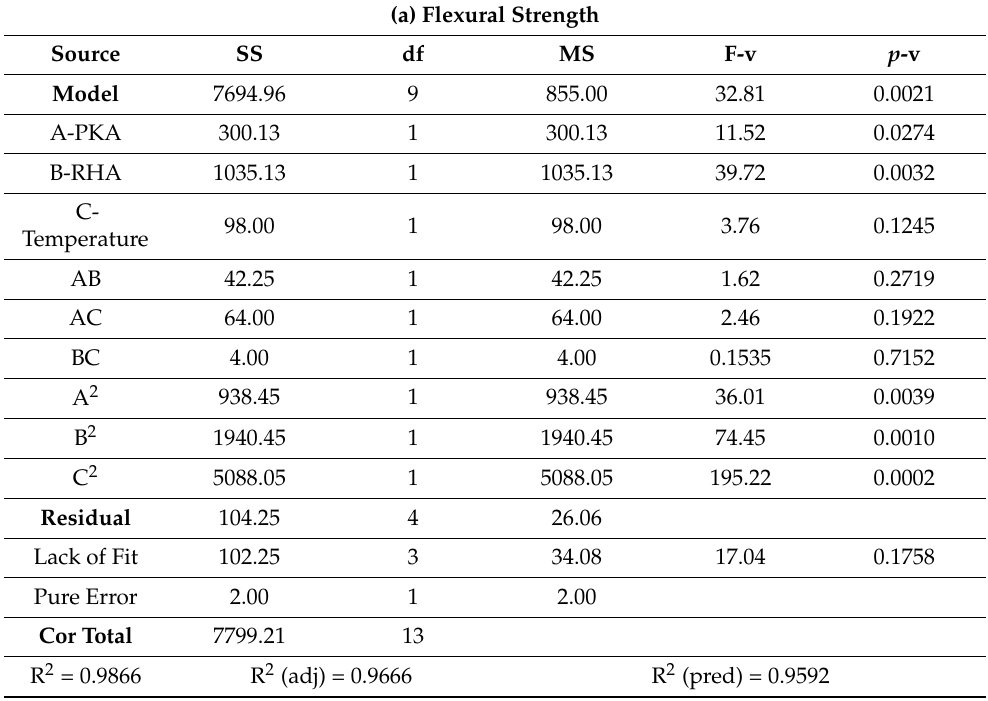
Table 9. Analysis of variance for flexural strength.